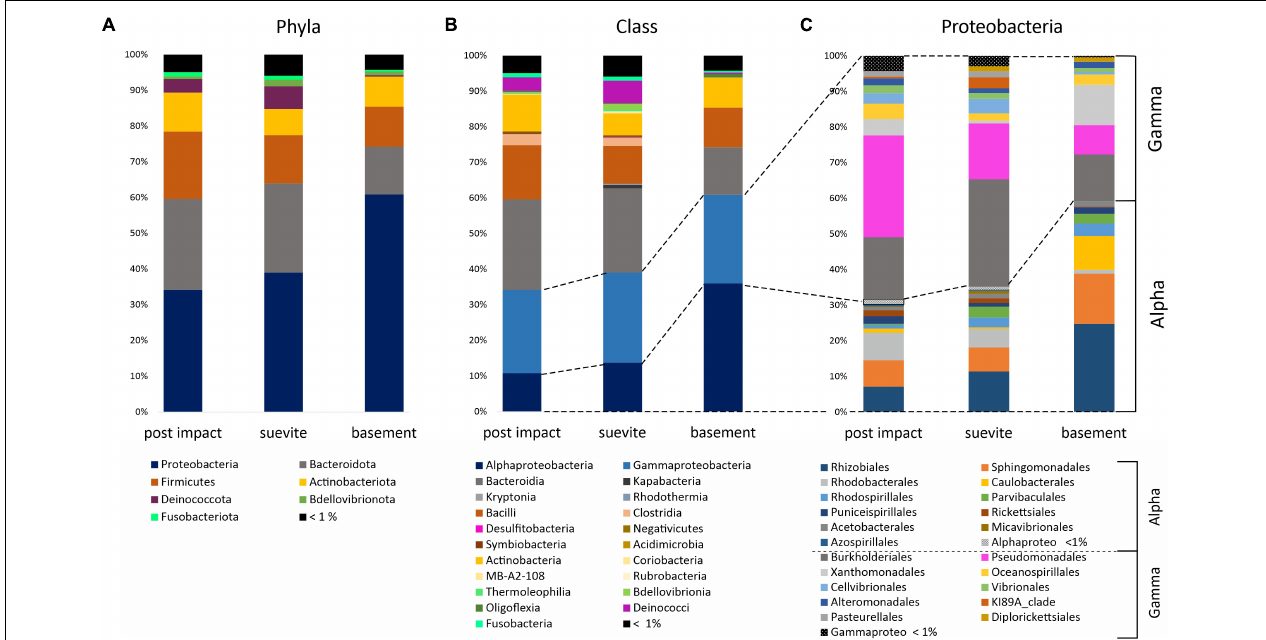
FIGURE 6 | Bar graphs showing the average distribution of the major phyla (A) , classes (B) , and orders for Proteobacteria (C) in the three lithologies: postimpact Cenozoic interval ( n = 32 samples), suevite ( n = 23), and granitic basement ( n = 7). See Supplementary Figure 5 for details on the relative abundance of the main phyla and classes in the three lithologies.